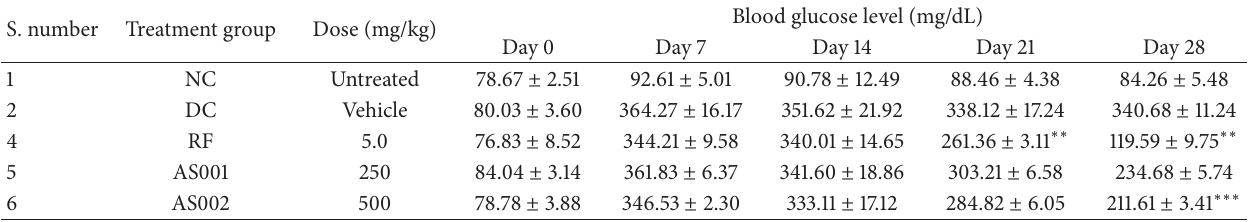
Table 3: Effect of Pupalia lappacea in blood glucose level of STZ induced diabetes in rats.